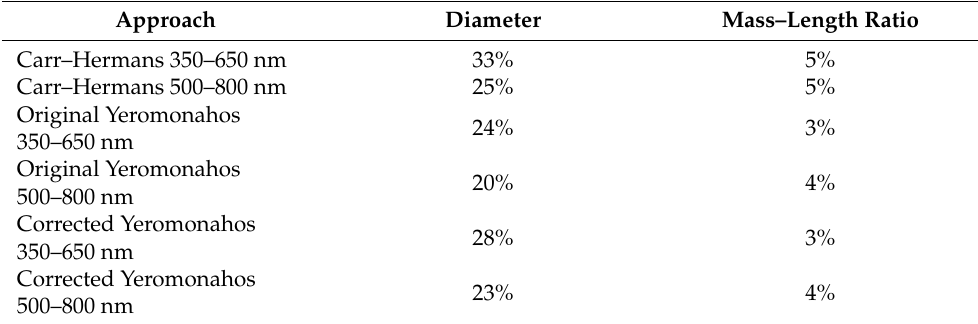
Table 1. Average difference in percent error for diameter and mass–length ratio calculated from numerical simulations with constant values of n and dn/dc (values at 633 nm) and wavelength- dependence corrected values of n and dn/dc (for HBS buffer).